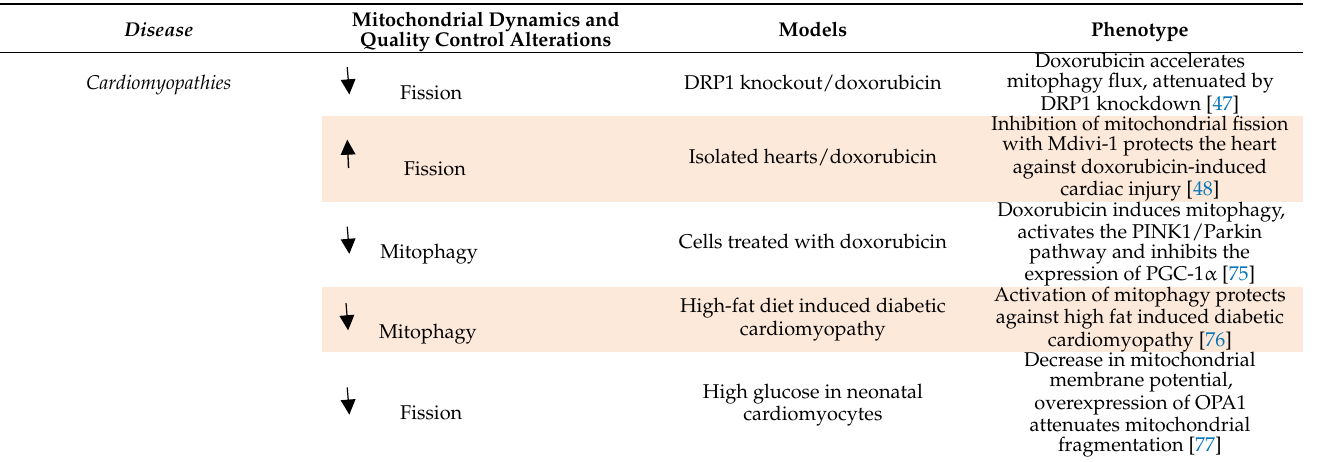
Table 1. Cont. Table 1. Mitochondria Quality Control Alterations in Cardiovascular Diseases.